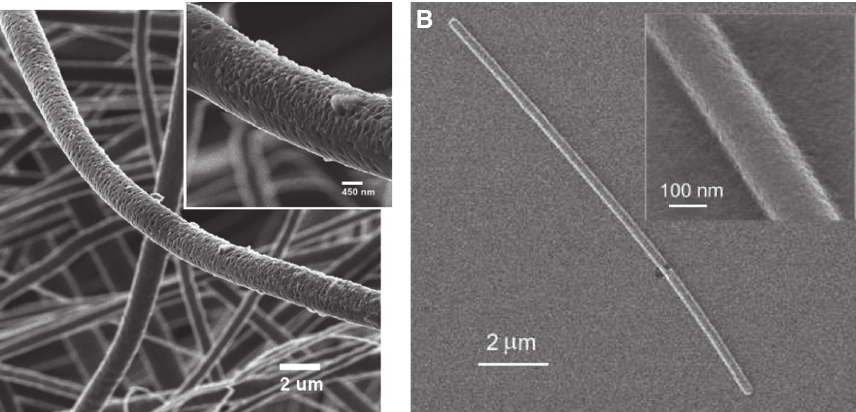
Figure 5 HIM imaging of polymer nanofibers: (A) electrospan PLLA nanofibers used as a scaffold (mineralization process can be seen on the surface); (B) self-organized fibers of polyaniline polymer. Insets show higher magnification images [Reproduced with permission from Carl Zeiss Microscopy, Peabody, MA,